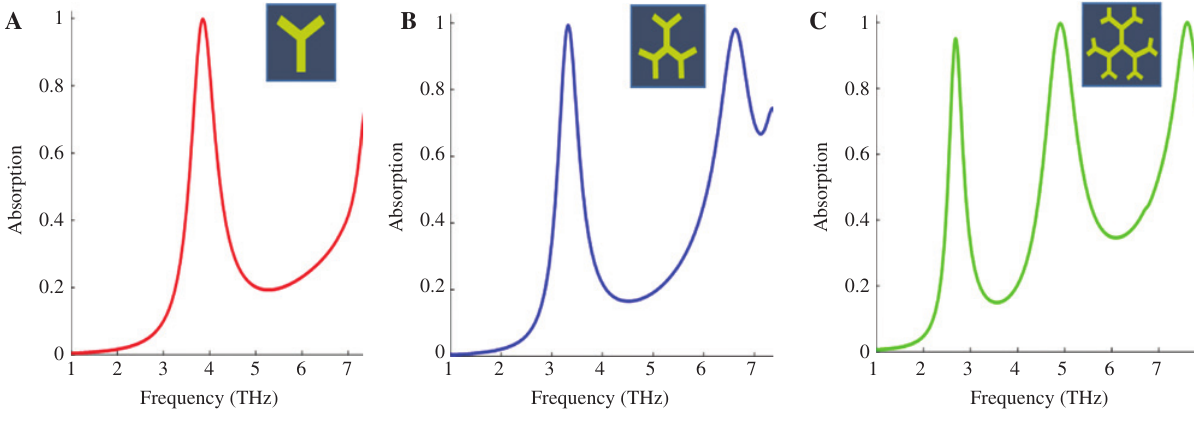
Figure 2: Absorption spectrum. (A) absorption of fractal order 1 Inset: first-order Cayley tree structure, (B) absorption of fractal order 2. Inset: second-order Cayley tree structure, (C) absorption of fractal order 3. Inset: third-order Cayley tree